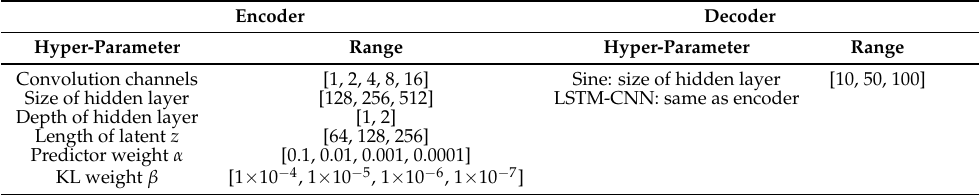
Table 4. Hyper-parameters of the semisupervised VAE approach. Encoder Decoder Hyper-Parameter Range Hyper-Parameter Range Convolution channels [1, 2, 4, 8, 16] Sine: size of hidden layer [10, 50, 100] Size of hidden layer [128, 256, 512] LSTM-CNN: same as encoder Depth of hidden